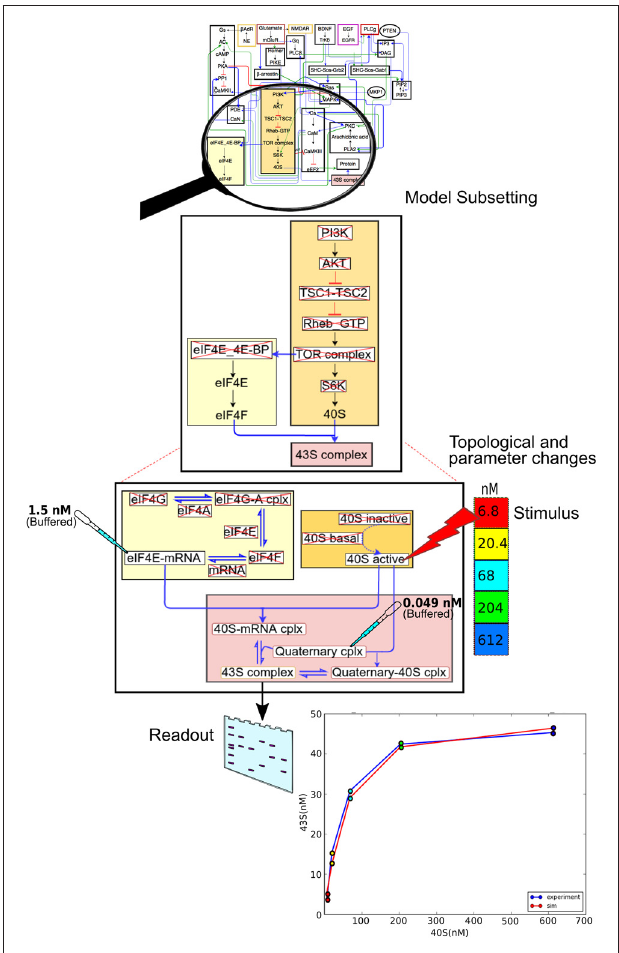
FIGURE 6 | Data flow using the model specification, experiment specification, model subset extraction, simulation and comparison with